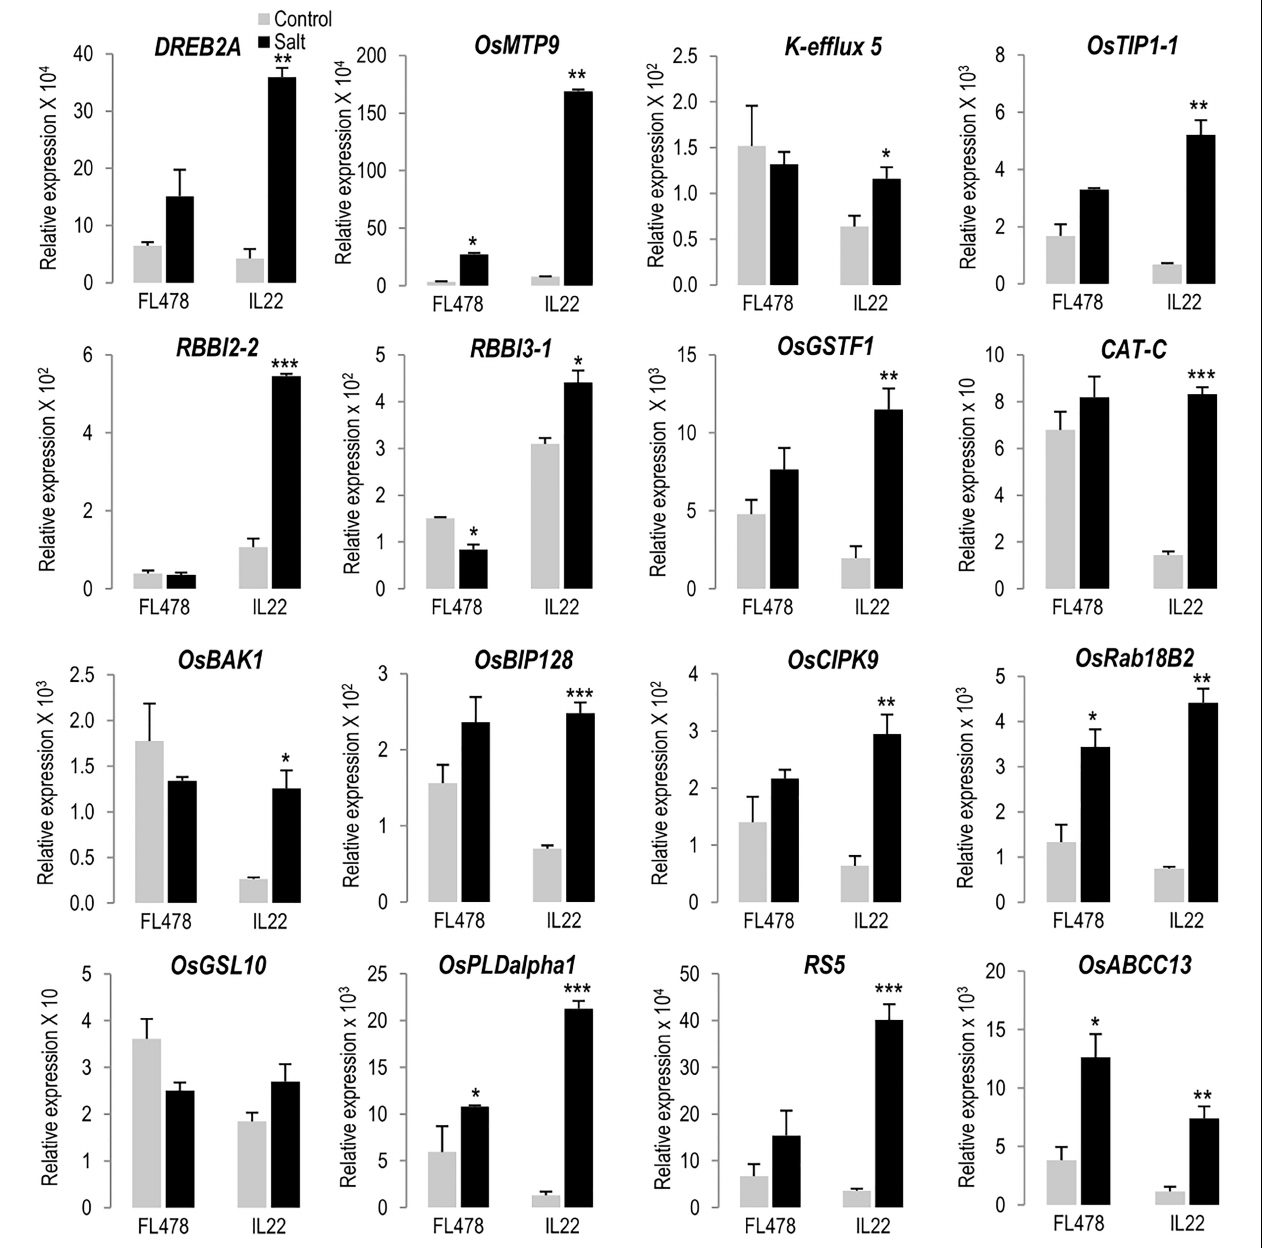
FIGURE 5 | Salt-responsiveness of genes identified in indica regions introgressed in IL22. Plants were grown in hydroponic cultures under control and salt-conditions (24 h of salt treatment, 80 mM NaCl). Transcript levels of the indicated genes were determined by RT-qPCR. OsUbi1 was used as the reference gene. Bars represent means of three biological replicates, each one from a pool of four different plants, ± SEM (Student’s t -test, * P ≤ 0.05, ** P ≤ 0.005, *** P ≤ 0.0005; salt-treated vs un-treated plants). DREB2A ( Dehydration responsive element binding 2A ), OsMTP9 ( Metal Tolerance Protein 9, manganese transporter), K + efflux 5 ( K + antiporter efflux 5 ), OsTIP1;1 ( Tonoplast intrinsic protein 1-1 ), RBBI2-2 ( Bowman–Birk proteinase Inhibitor 2-2 ), RBBI3-1 ( Bowman–Birk proteinase Inhibitor 3-1 ), OsGSTF1 ( Glutathione-S-transferase F1 ), CAT-C ( Catalase C ), OsBAK1 [ Brassinosteroid Insensitive 1 (BRI1)-associated receptor kinase 1 ], OsBIP128 [ Brassinosteroid receptor kinase (BRI1)-interacting protein 128 ], OsCIPK9 ( Calcineurin B-like interacting protein kinase 9 ), OsRab18B2 ( Ras-related in brain 18 B2 ), OsGSL10 ( Glucan Synthase-Like 10, callose synthase 10 ), OsPLDalpha1 ( Phospholipase D alpha 1 ), RS5 ( Raffinose synthase 5 ), OsABCC13 ( ATP Binding Cassette transporter B 13 ). Primers and locus ID are listed in Supplementary Table 2